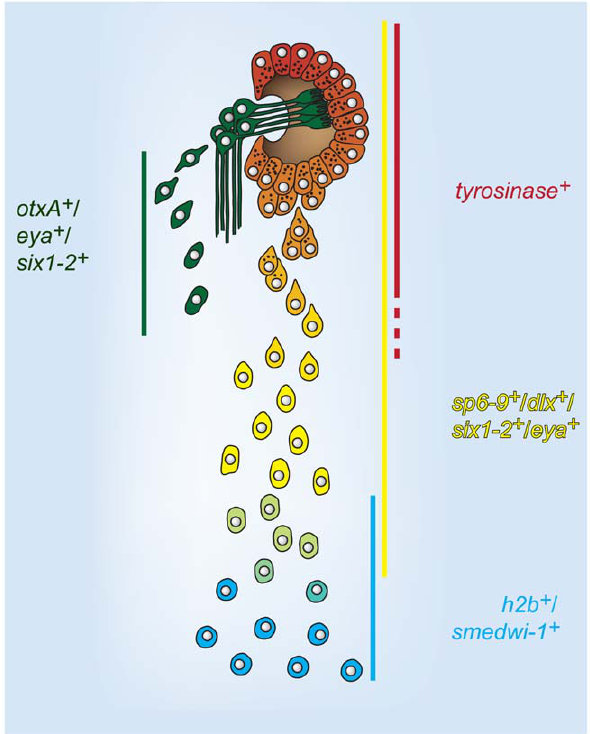
Figure 7. A model for cell state changes in pigment cup regeneration. Lines indicate domain of expression of the adjacent gene labels in the optic cup trail during regeneration. Regenerative photoreceptor neuron cells are shown as spatially separated for clarity. This model proposes that optic cup progenitors are specified at distance from the aggregated cells of the optic cup primordium, within the neoblast population ( h2b + , smedwi-1 + ). Progenitors undergo changes in gene expression, including loss of neoblast markers and activation of differentiation markers, as migration towards the eye primordium proceeds. Ultimately, terminally differentiating progenitors incorporate into the eye and undergo a mesenchymal-to-epithelial